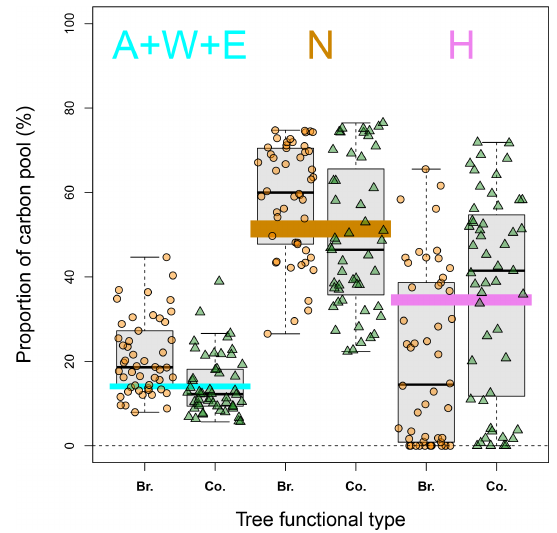
Figure 6. Distribution of estimated carbon quality based on the par- tial steady-state assumption (box plots) versus those based on the complete steady-state assumption (whose ranges are all very nar- row and are expressed with strips in color: 13%–15% for the sum of A, W and E – cyan; 49%–53% for N – brown; and 33%–36% for H – purple). For each box plot, the low and top edges of the box correspond to the 25th and 75th percentile data points, respectively; the line inside the box represents the median, and there are no out- lier points in this case. Br. – broadleaved stands; Co. – coniferous